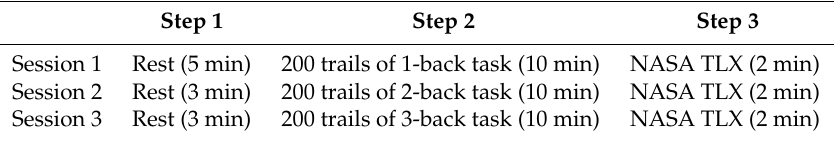
Table 1. Experiment with 3 sessions according to 1-, 2-, 3-back